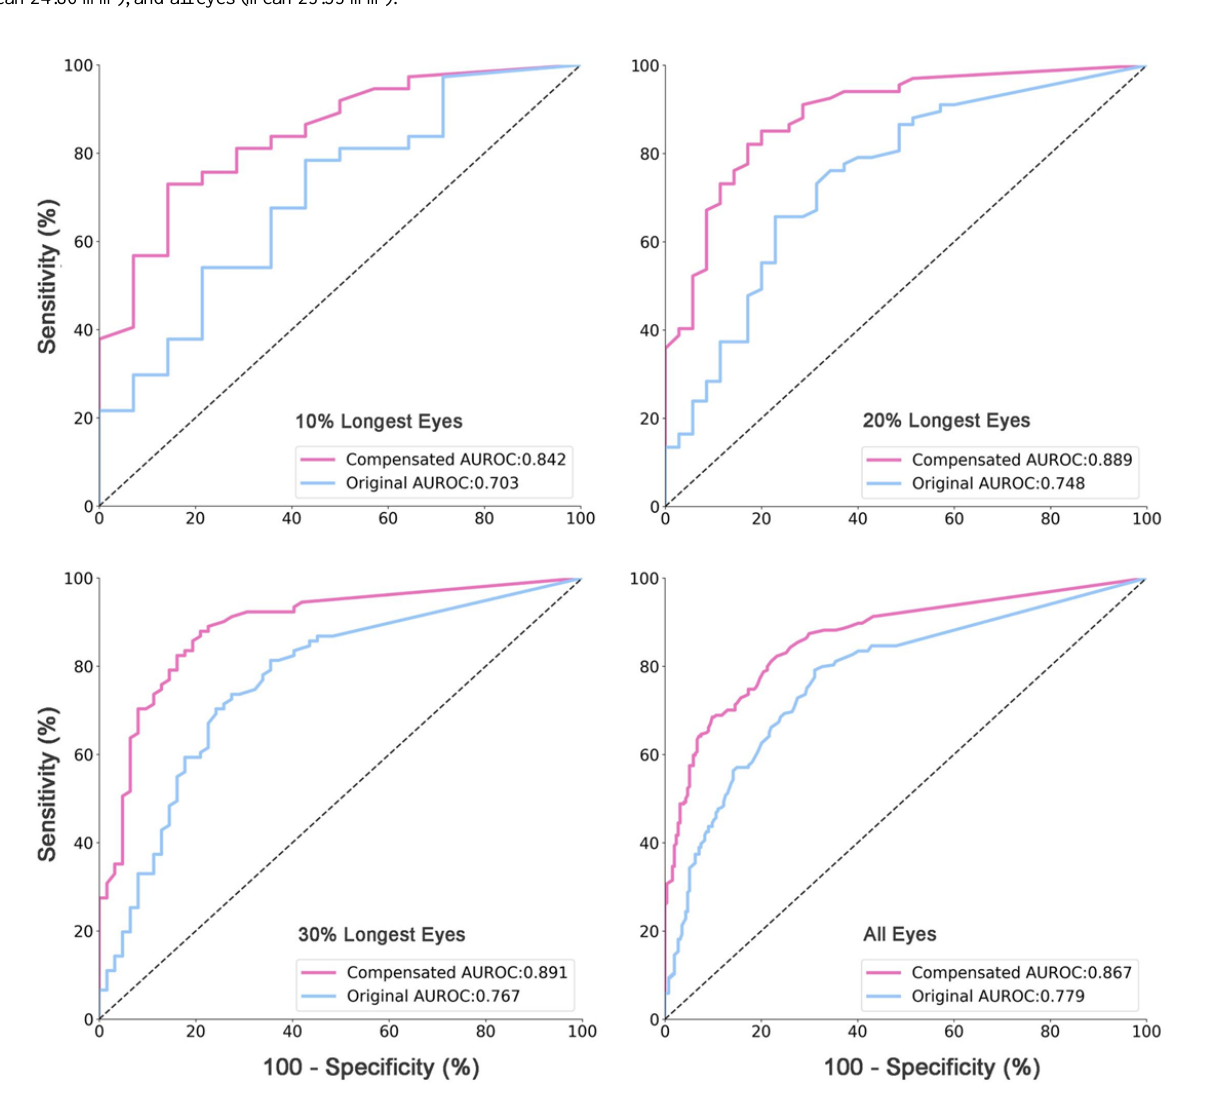
Figure 4. Area under receiver operation curve (AUROC) for the detection of glaucoma in the validation data set before (blue line) and after (pink line) the transformation, in eyes of the 10% longest axial length (mean 26.01 mm), 20% longest axial length (mean 25.26 mm), 30% longest axial length (mean 24.86 mm), and all eyes (mean 23.53